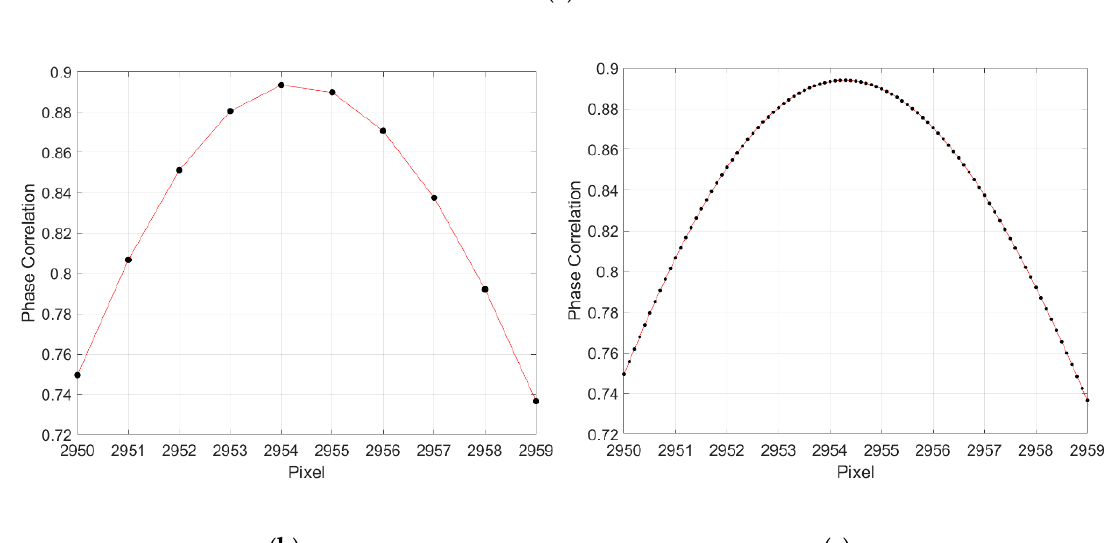
Figure 6. Phase correlation of two 1D images. ( a ) Full phase correlation plot; ( b ) Enlarged phase correlation plot; ( c ) Up-sampled phase correlation (up-sampling factor p = 10).